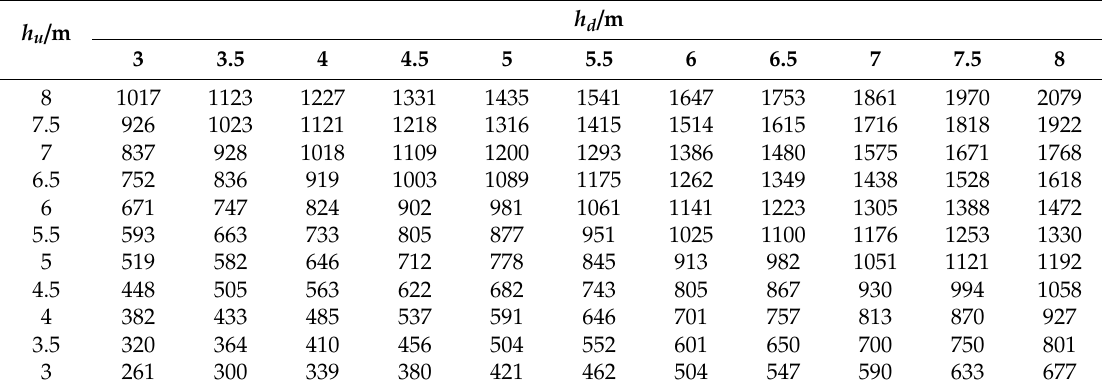
Table 1. Integral of instantaneous power, P int , at di ff erent h u and h d .